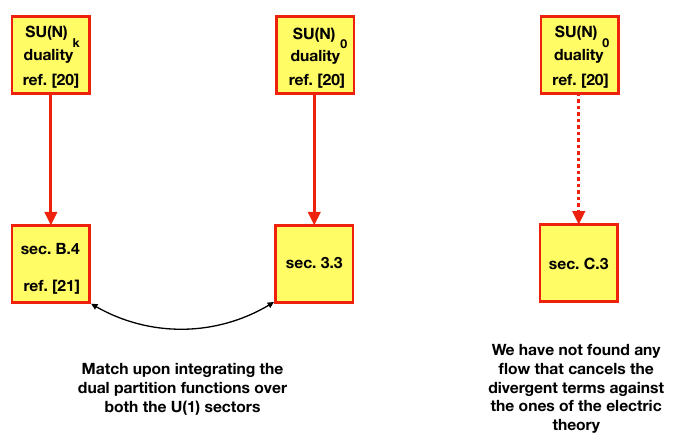
Figure 3 . The various real mass flows leading to the [ p, q ] ∗ case studied in this paper and their relation. We report the references corresponding to the UV duality where the RG flows considered here